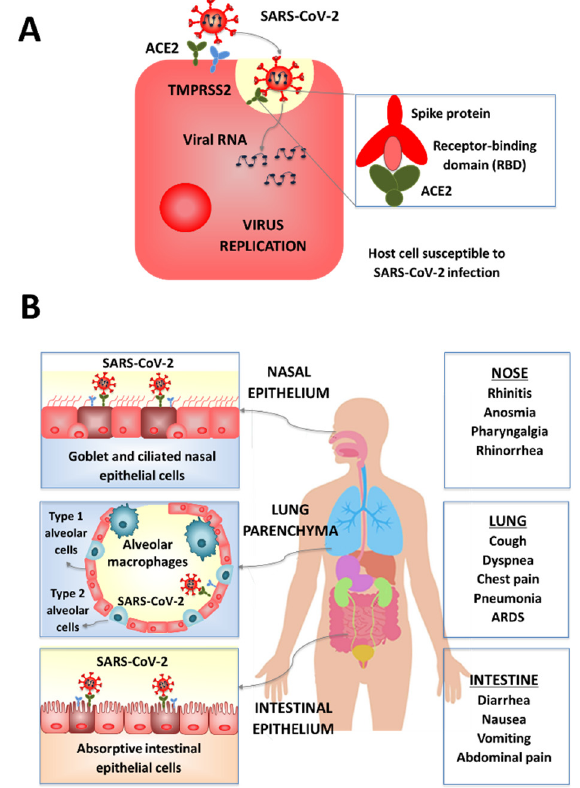
Figure 2. Mucosal tissues susceptible to SARS-CoV-2 infection. The virus infects mucosal cells expressing the surface receptors ACE2 and TMPRSS2 ( A ), and the active replication cause the death of cells, inducing respiratory and intestinal alterations ( B ).